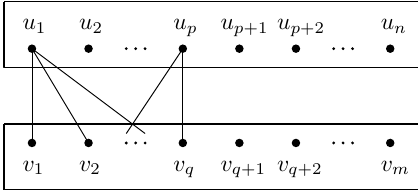
Figure 1: The graph G used in the proof of Theorem